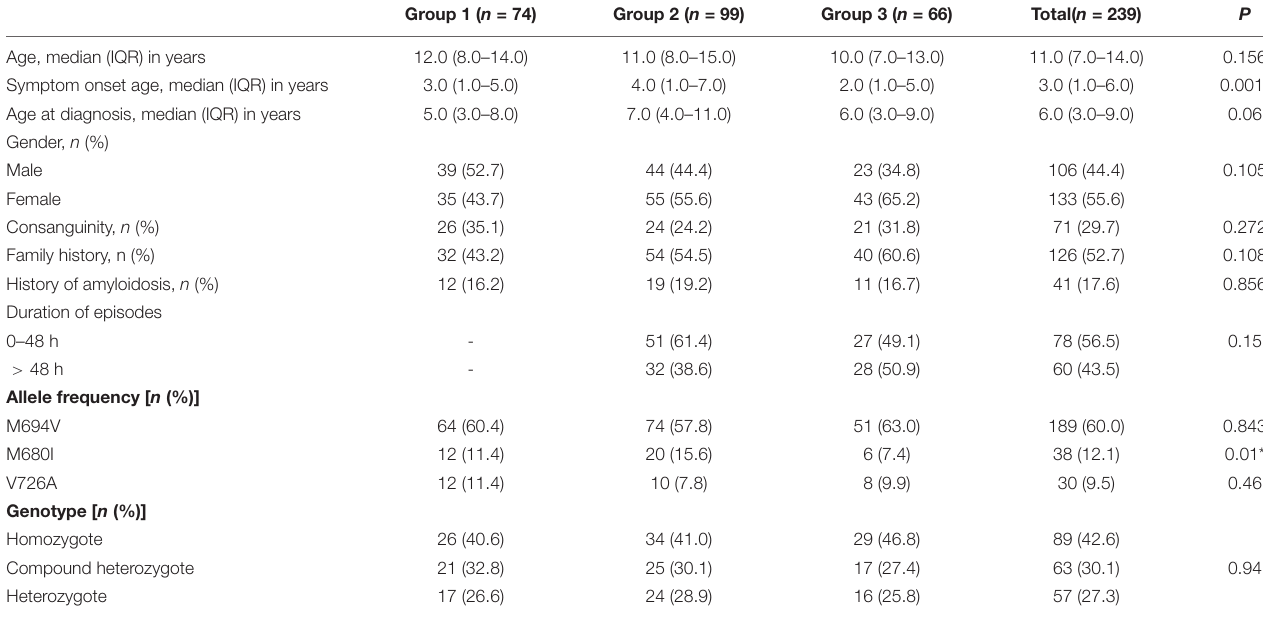
TABLE 1 | Demographic features and comparisons among the groups by the number of Familial Mediterranean fever (FMF) episodes. Group 1 ( n = 74) Group 2 ( n = 99)